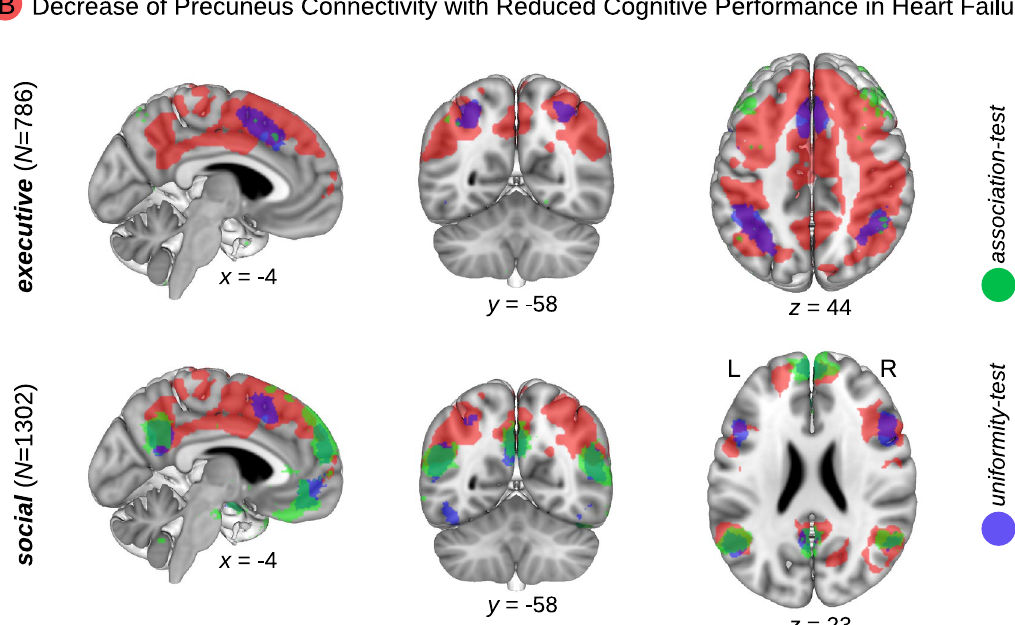
Figure 4. Meta-analytical data-mining shows that neural networks affected by heart failure (HF) are mainly related to executive and social abilities—Neurosynth database. Brain connectivity decrease in HF in the precuneus (top panel, A ) and the neural network originating from a seed-based correlation analysis showing decreased precuneus connectivity with reduced cognitive performance in HF (bottom panel, B ) are illustrated in red color (data are identical to Fig. 1A, C). Overlap between the aforementioned regions and neural correlates of social and executive functions as extracted from the meta-analytical Neurosynth database, another very large independent cohort. Results are shown for the association test (green color) and the uniformity test (blue color). False discovery rate of 0.01. x, y, z—coordinates of the Montreal Neurological Institute (MNI) stereotactic space. L—left,